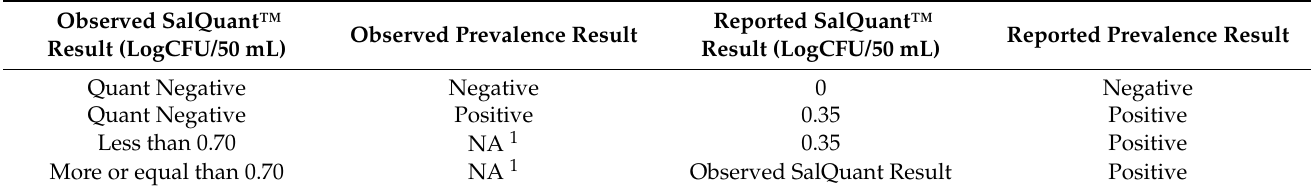
Figure 4. Generic E. coli (EC) counts in LogCFU/mL (g) at each processing stage throughout the pork processing line ( n = 50; N = 650). The LOD at harvest is 6 CFU/mL (0.78 LogCFU/mL); for trim and further process samples 5 CFU/g (0.70 LogCFU/g). In the boxplot, the horizontal line crossing the box represents the median, the top and bottom lines represent the lower (0.25) and upper (0.75) quartiles, the vertical top lines represent 1.5 times the interquartile range and the vertical bottom line represents 1.5 times the lower interquartile range. The dots represent actual data points. Box plots with different letters (a–d); (x–z) represent statistical significant differences according to Kruskal–Wallis analysis followed by pairwise comparison with Wilcoxon’s test at p -value < 0.05. PAA (Peroxyacetic acid); AMR (Advanced Meat Recovery). Table 4. Observed and reported parameters established for Salmonella quantification and prevalence analysis for pork carcass